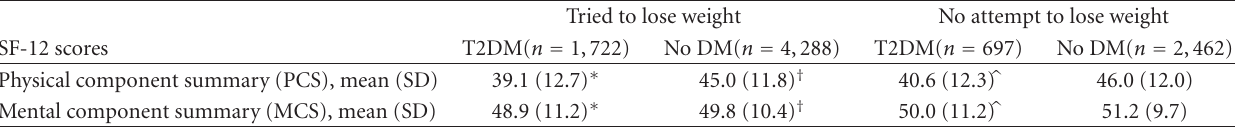
Table 3: SF-12 scores for respondents with and without diabetes who did and did not try to lose weight.